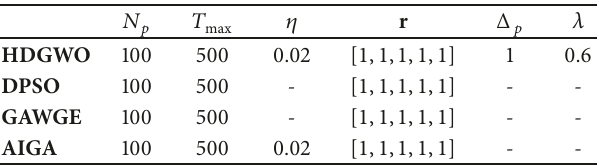
Table 2: The necessary input parameters of the HDGWO, the DPSO, the GAWGE, and the AIGA.